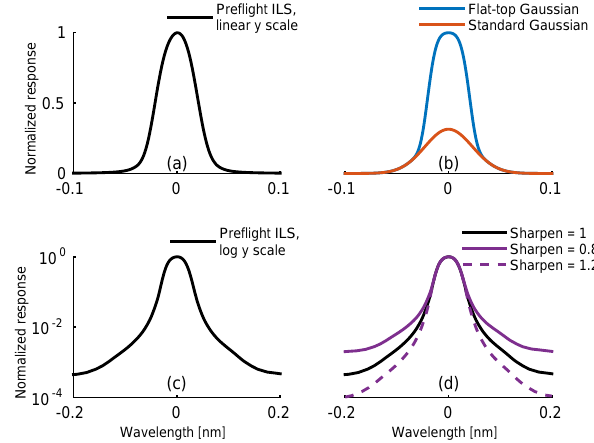
766nm for footprint 5. (b) shows the derived hybrid asymmetric Gaussian, decomposed into flat-top and standard Gaussians, from fitting the corresponding solar spectrum microwindow (window 2 at the O2A band; see Fig. 2). (c) is the same as (a) but in log y scale. (d) shows the differences between the sharpen terms of 0.8, 1,